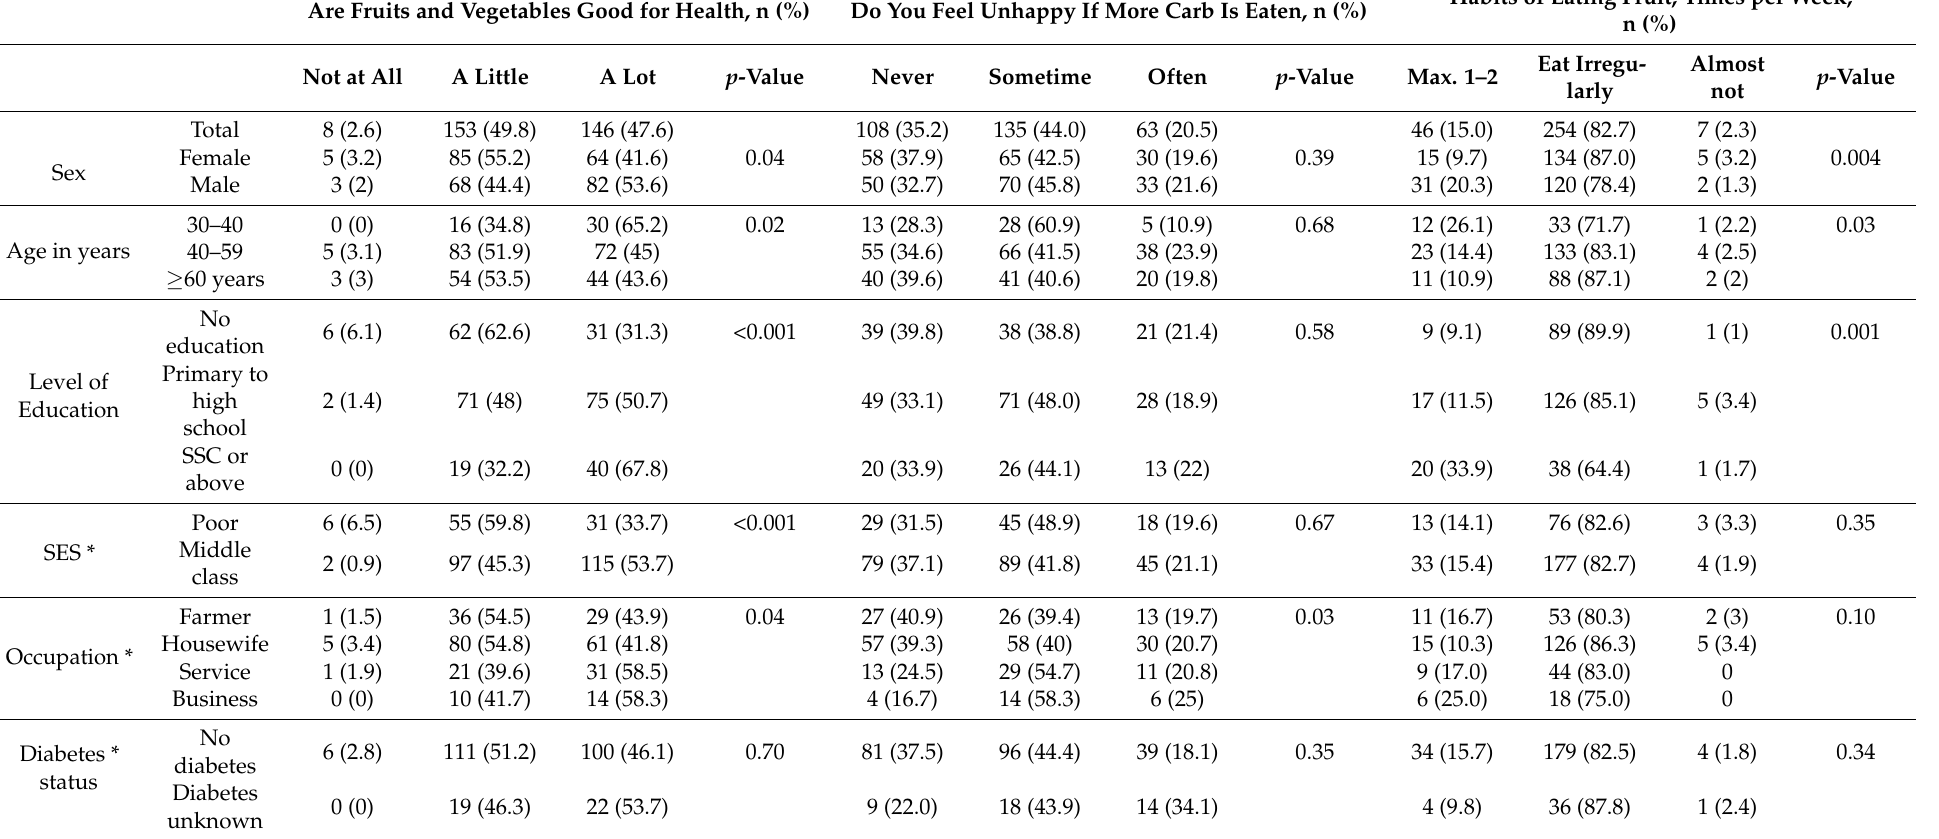
Table 3. Fruit consumption habits, and knowledge and attitudes towards fruits consumption and their associated factors. Are Fruits and Vegetables Good for Health, n (%) Do You Feel Unhappy If More Carb Is Eaten, n